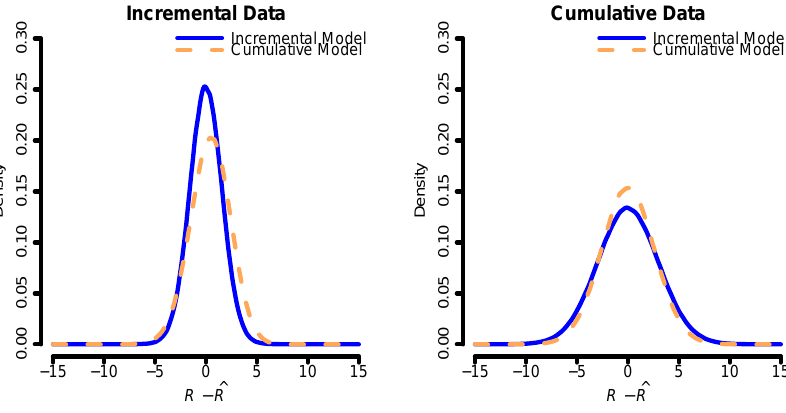
Figure 2. Distribution of the prediction error for the incremental and cumulative models when fitted to incremental data (left) and cumulative data (right). Values are in millions.